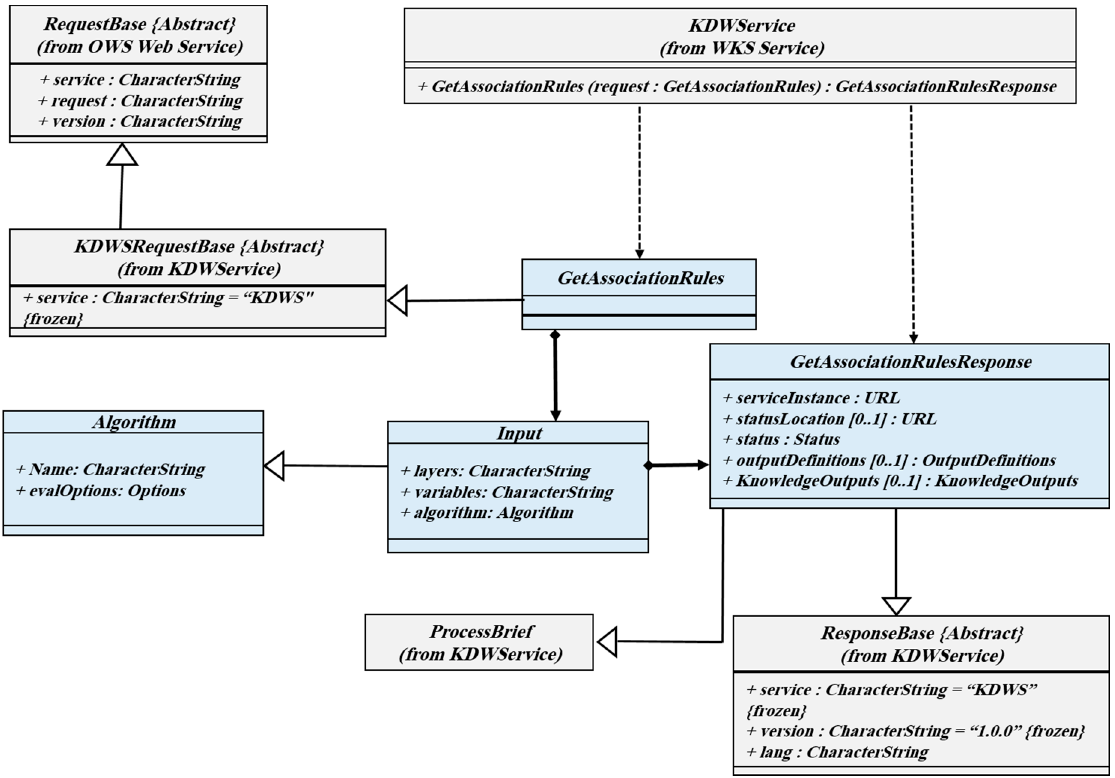
Figure 8. The class diagram of the GetAssociationRules operation.